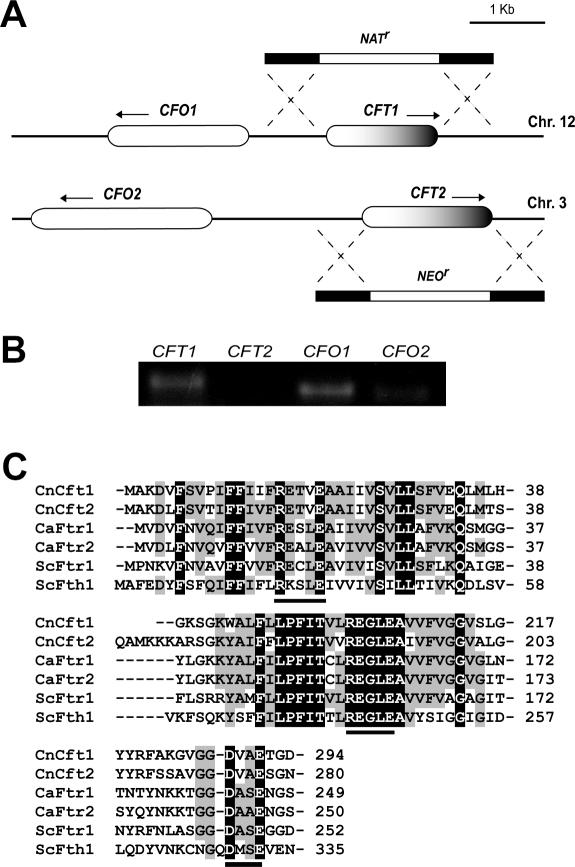
Genomic Arrangement and Conserved Regions of CFT1 and CFT2
(A) CFT1 and CFT2 are located on chromosomes 12 and 3, respectively. The genes were disrupted by transforming the disruption cassette containing the selectable marker for resistance to nourseothricin (NAT
r) or neomycin (NEO
r) as shown.(B) Basal levels of the transcripts are shown for the genes indicated above the lanes. The cells were grown under low-iron conditions and transcripts were amplified by RT-PCR (30 cycles).(C) Comparison of specific regions of the predicted amino acid sequences of Cft1 and Cft2 with the high-affinity iron permeases in other fungi. Both Cft1 and Cft2 contain the highly conserved motifs underlined. CnCft1: C. neoformans Cft1 from strain H99; CnCft2: C. neoformans Cft2 from strain H99; CaFtr1: C. albicans CaFtr1 (AAF69680); CaFtr2: C. albicans CaFtr2 (AAF69681); ScFtr1: S. cerevisiae Ftr1 (NP_011072); ScFth1: S. cerevisiae Fth1 (CAA85171).